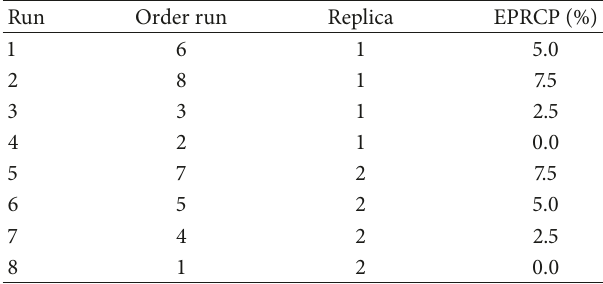
Table 1: Experimental desing ∗ to obtain extruded cereal using encapsulated powder of red cactus pear (EPRCP) as